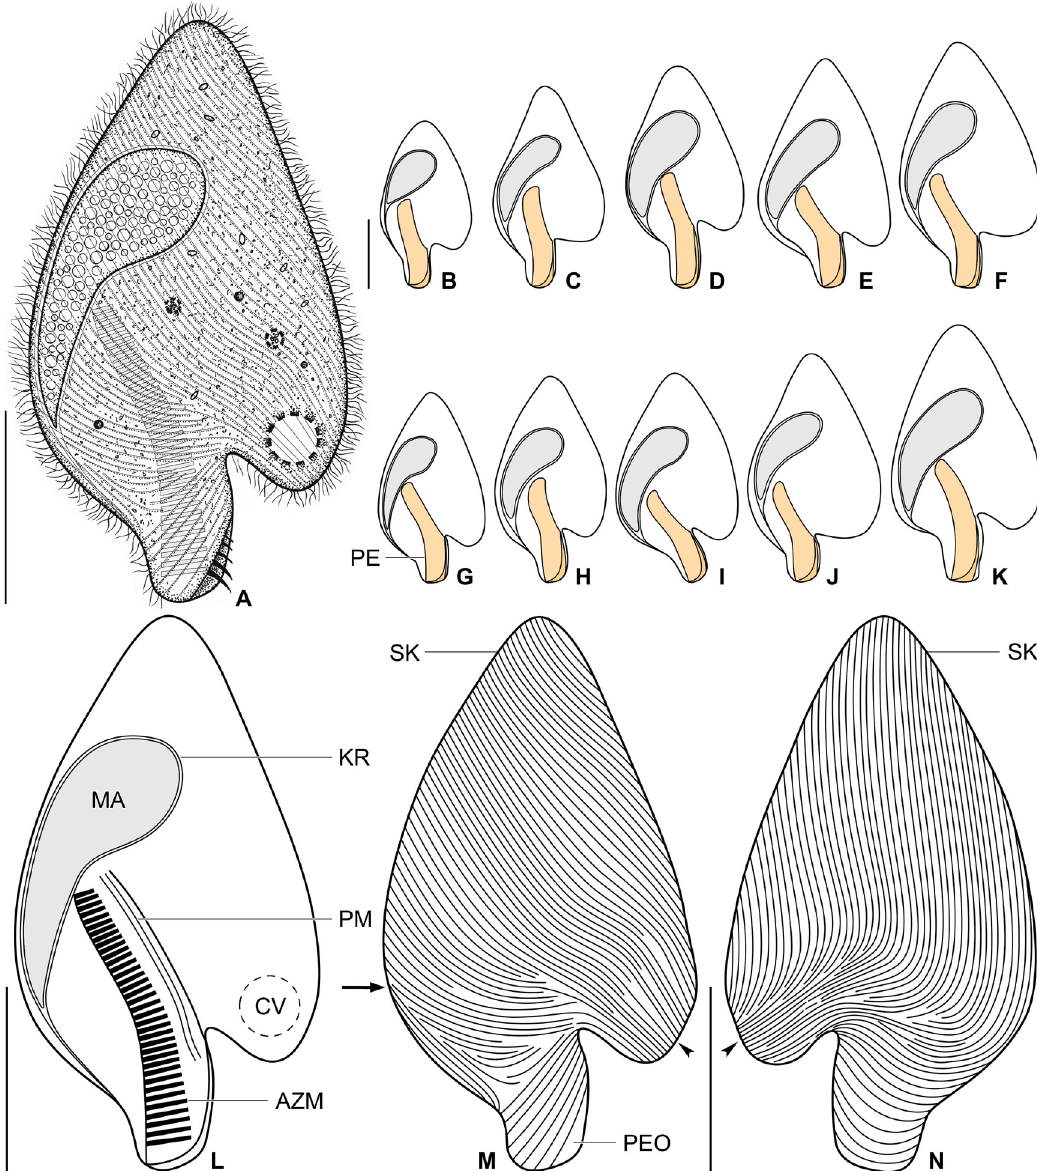
Fig. 9. Clevelandella parapanesthiae (Kidder, 1937). Thai I specimens isolated from Panesthia angustipennis angustipennis (Illiger, 1801) from life (A) and after protargol impregnation (B–N). A . Ventral view of a representative specimen, length 90 μm. B–K . Variability of body shape and size as well as of the nuclear (shaded grey) and oral (shaded yellow) apparatus. L . Semi-schematic diagram, showing the general body organization. M–N . Ciliary pattern of ventral and dorsal sides. Arrow marks the right suture, black arrowheads indicate the position of the ciliary whorl (posterior suture). Scale bars = 30